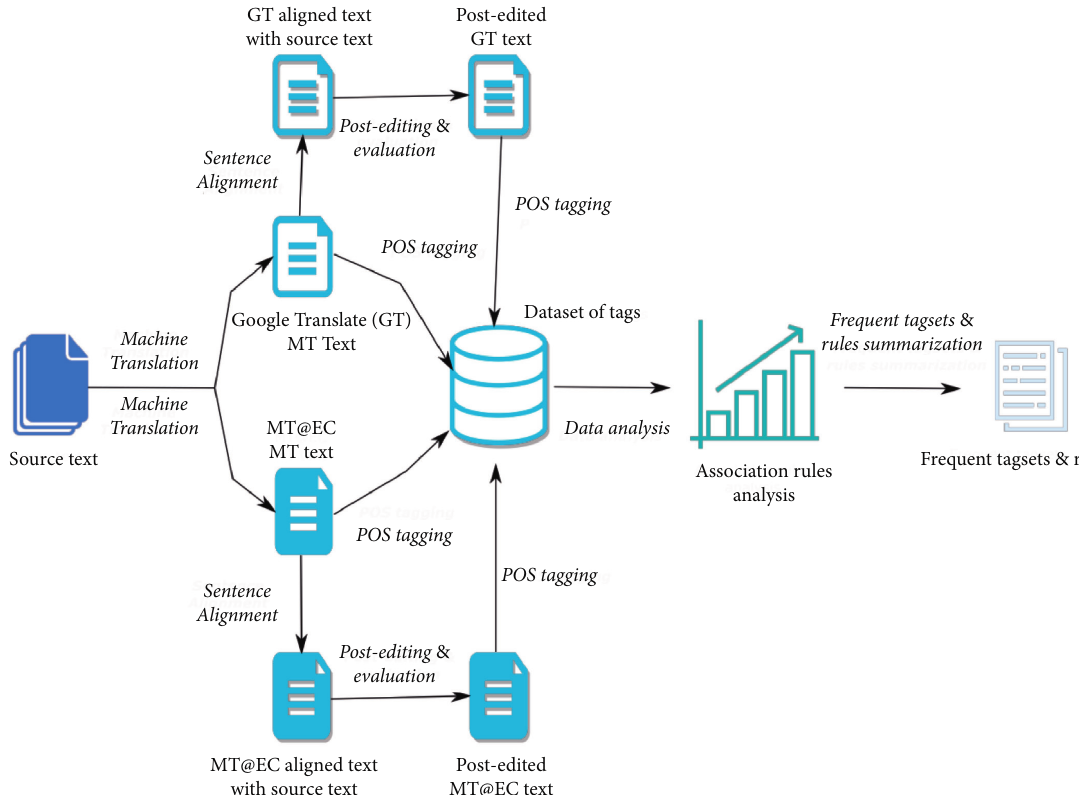
Figure 1: The proposed